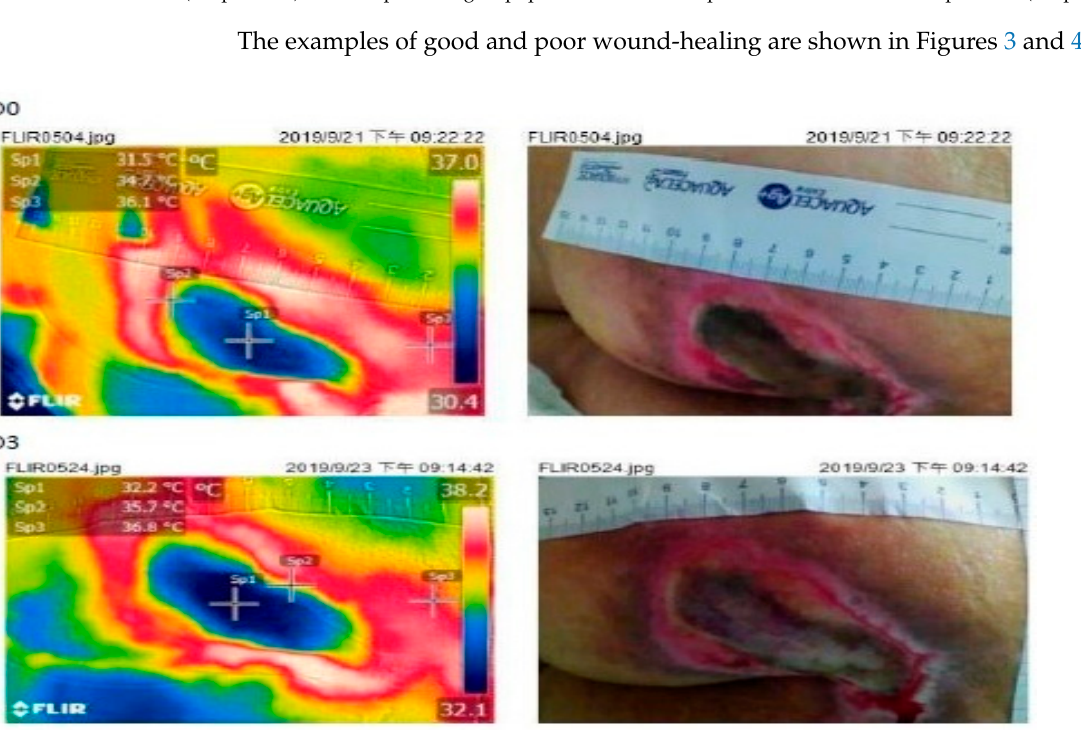
Figure 4. Case of poor wound-healing (upper to lower in the consecutive days). IRTc: wound bed (Sp1) IRTp: periwound skin (Sp2); IRTn: normal skin (Sp3).